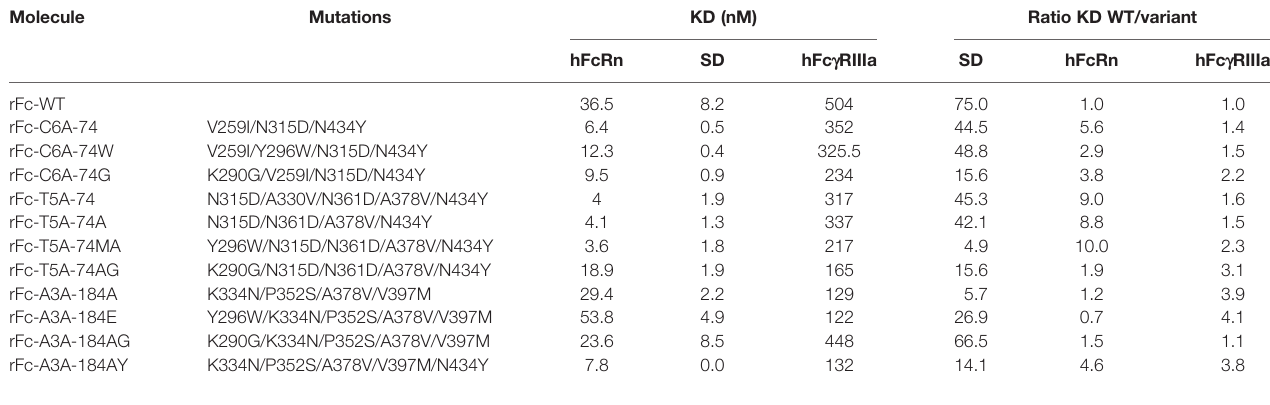
TABLE 1 | KD determined by BLI (Octet device) of 8 new mutants vs initial variants at pH6.0 for hFcRn and pH7.4 for hFc g RIIIa (KD determined as means of 3 experiments). Molecule Mutations KD